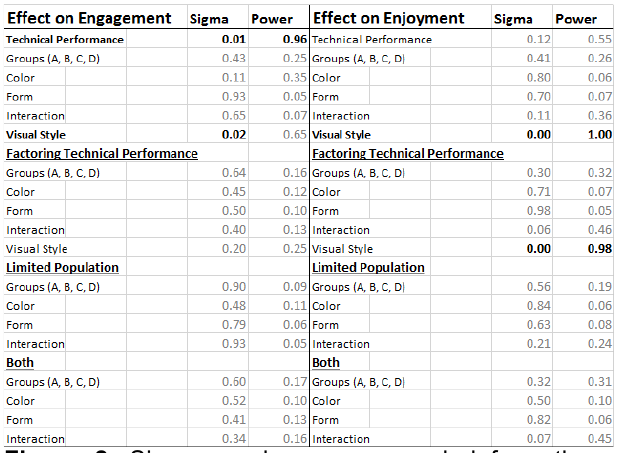
Figure 2. Sigmas and powers recorded from the statistical analyses. Tests that accounted for the impact of technical performance, used a subset of the total sample, or both, are clearly labelled